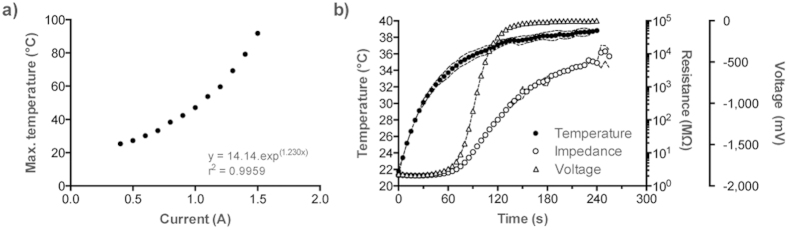
Heat response behaviour of H-tubes.(a) Dependence of the maximum temperature of a glass tube on the applied current. (b) Example of the increase of resistance of a H-tube in response to heat generated by a 0.8 A current through the heating element. Dashed lines represent standard deviation (n = 3).